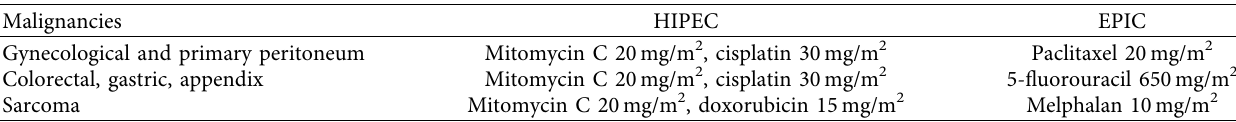
Table 1: HIPEC/EPIC